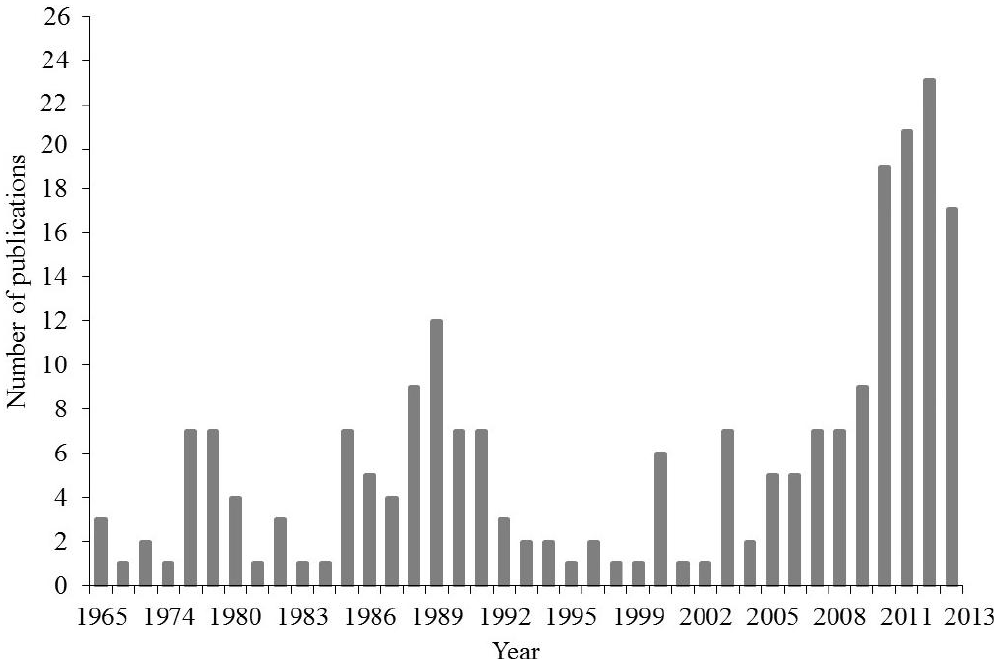
Figure 2. The number of articles on electric current-assisted consolidation published since 1965 in the former USSR and post-soviet